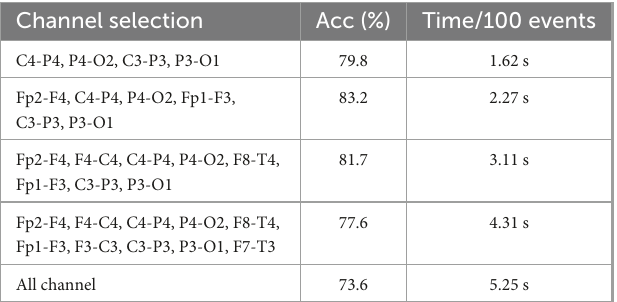
TABLE 2 Selection of different channels and running time of every 100 events. Channel